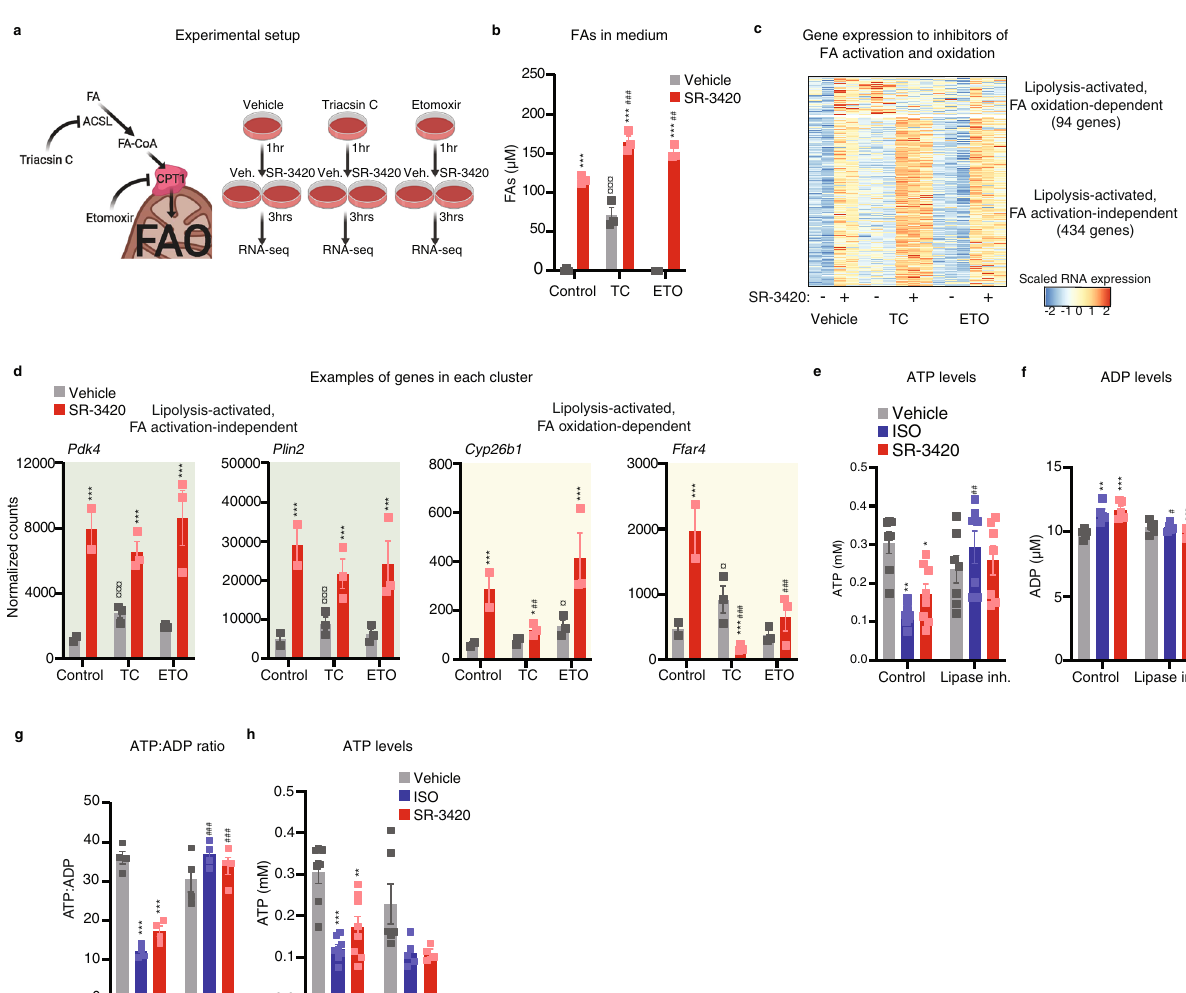
Fig. 2 Lipolysis activates gene expression independent of fatty acid activation or oxidation. Mouse in vitro differentiated brown adipocytes were pre- treated with 5 µ M triacsin C (TC; ACSL inhibitor) or 50 µ M etomoxir (ETO; CPT1A inhibitor) for 1h and subsequently with 20 µ M SR-3420 (red bar) for 3